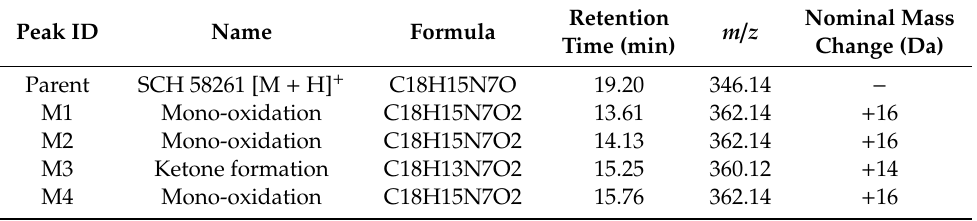
Table 7. Characteristics of in vitro SCH 58261 metabolite identification results by LC–MS / MS assay.